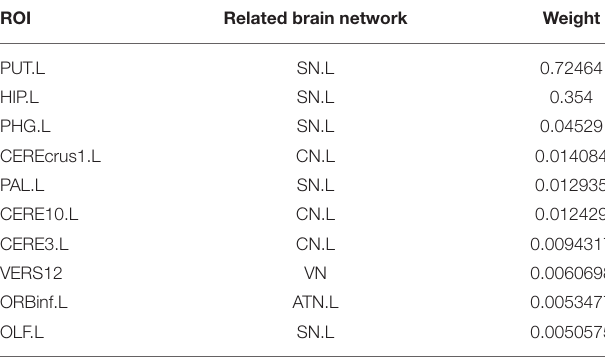
TABLE 4 | Top 10 ROIs of d-fALFF identified by our